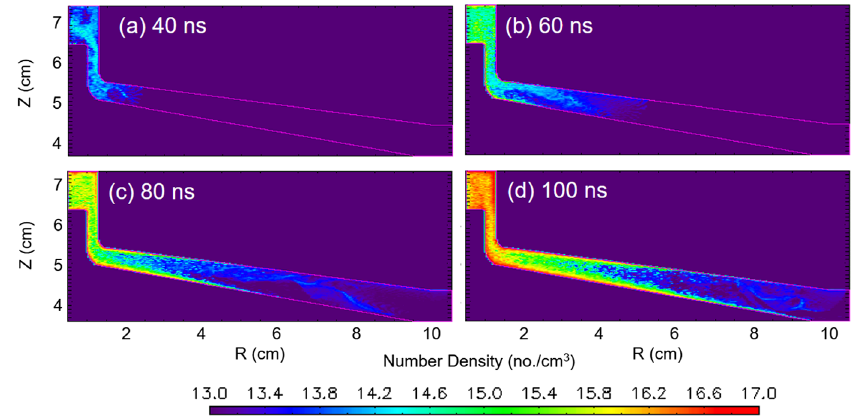
FIG. 8. For the p ¼ 10 − 5 Torr simulation, the ion density is plotted at (a) 40, (b) 60, (c) 80, and (d) 100 ns. Plasma desorbed via the Temkin